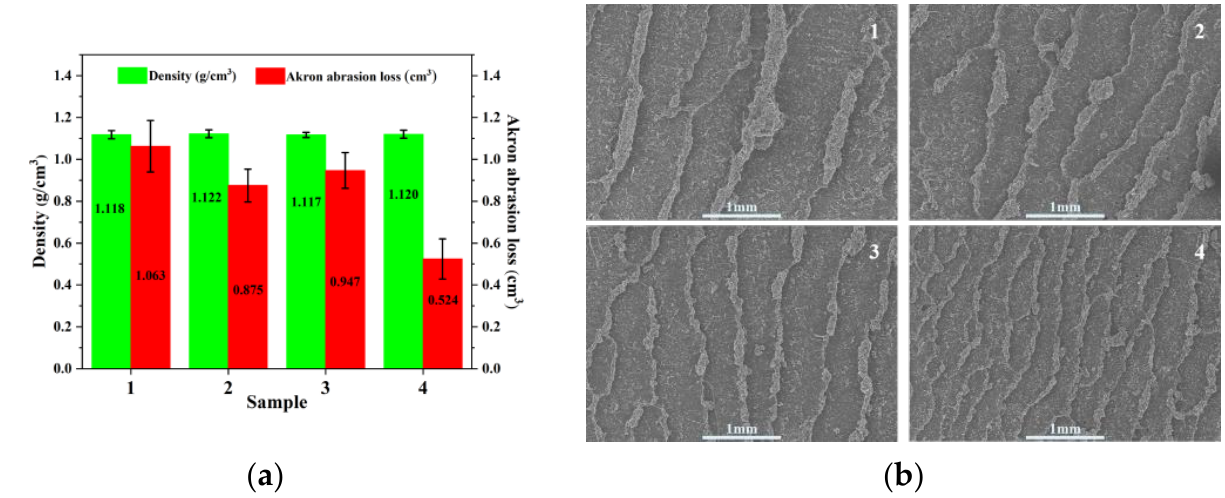
Figure 10. ( a ) The Akron abrasion and density of rubber composites; ( b ) SEM of the wear surface morphology of the rubber composite. (1) SiO 2 /EUG/SBR; (2) MEST-SiO 2 /EUG/SBR; (3) SiO 2 /EEUG/EUG/SBR; (4) MTES-SiO 2